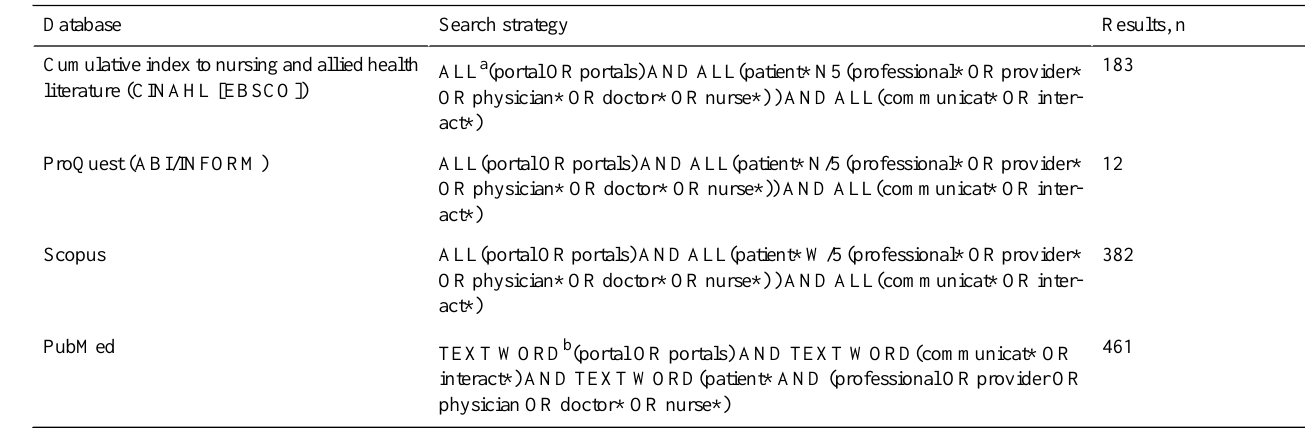
Table 1. Databases, search strategy, and results identifying the studies.